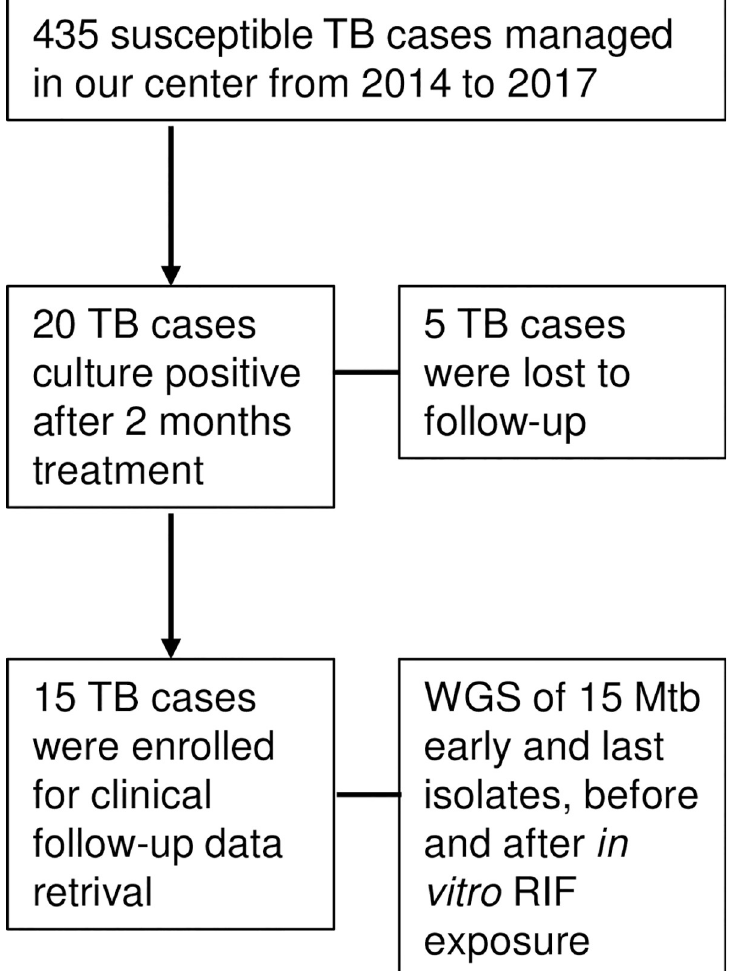
Fig 1. Flowchart of delayed conversion TB patients enrollment for WGS of early and last Mtb isolates, before and after in vitro rifampicin (RIF) exposure.